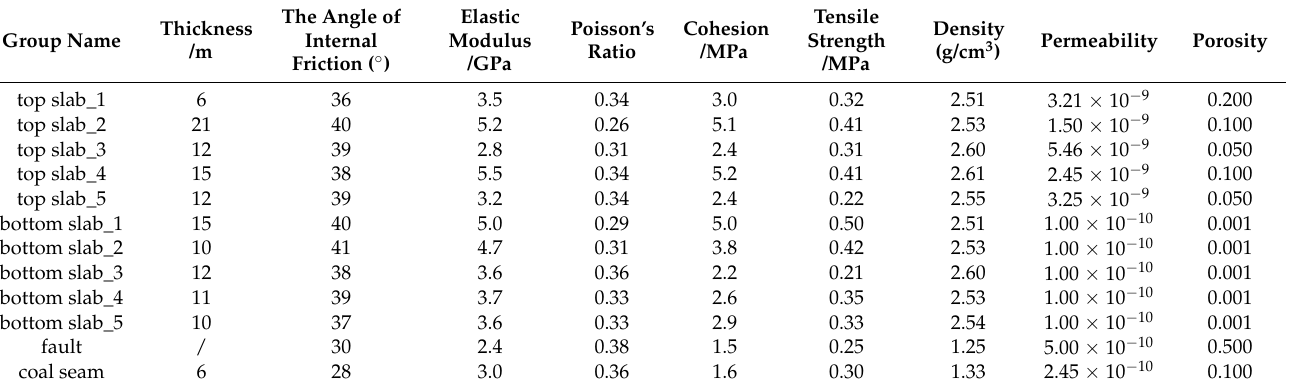
Table 1. Mechanical parameters of